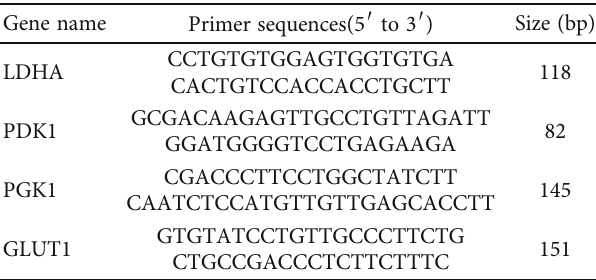
Table 1: The primer of genes. Gene